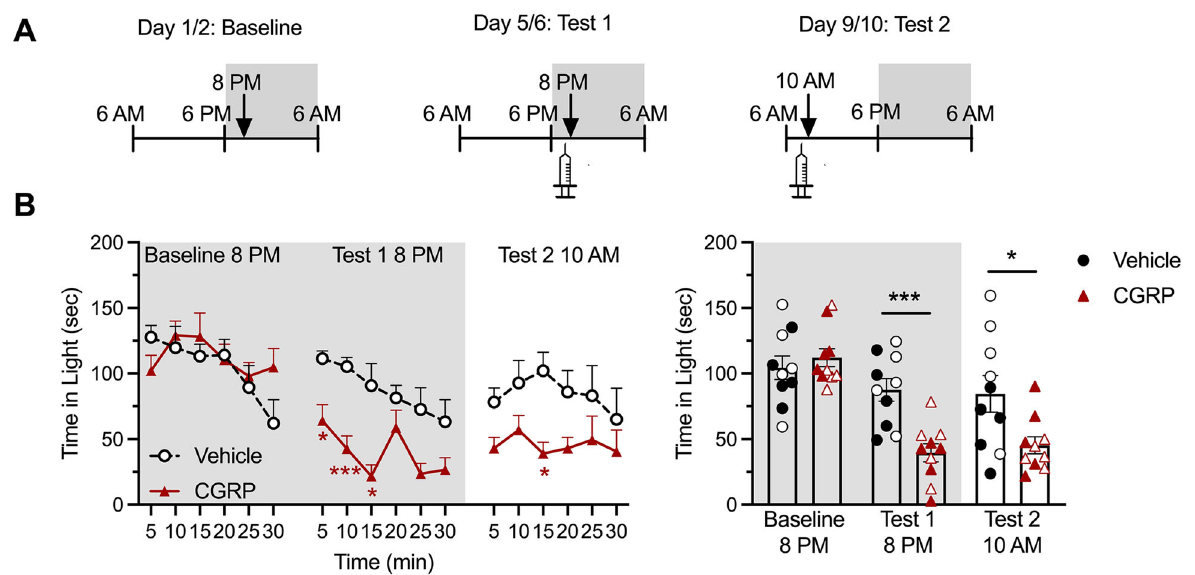
Fig. 4 Peripheral CGRP induces light aversion during both the active and inactive phases (reverse testing from Fig. 3). In all panels, grey areas represent the active phase of the animals when lights of the facility were turned off (night). Empty symbols represent females, and full symbols represent males. There were no statistical differences between males and females. A Experimental design: Mice were first baselined during their active phase (experiment starting at 8:00 pm), and then exposed to treatments on the first test day during their active phase (8 pm), and second test day during their inactive phase (experiment starting at 10:00 am). B Left panel. Time spent in the light zone by CD1 mice during sequential exposures to the light/dark chamber at 25,000 lx. On test days, animals were tested 30 min after injection of vehicle (PBS, i.p., n = 10) or CGRP (0.1 mg/kg i.p., n = 10). Two-way (factors: time x treatment) ANOVA, Sidak ’ s multiple comparison test * p < 0.05, ** p < 0.01 and *** p < 0.001 compared to corresponding time point in vehicle group. Right panel. Mean time (± SEM) spent in the light zone per 5 min interval for individual mice during the same experiment represented in (C). Unpaired t-test ** p < 0.01 and *** p < 0.001 comparing CGRP group with